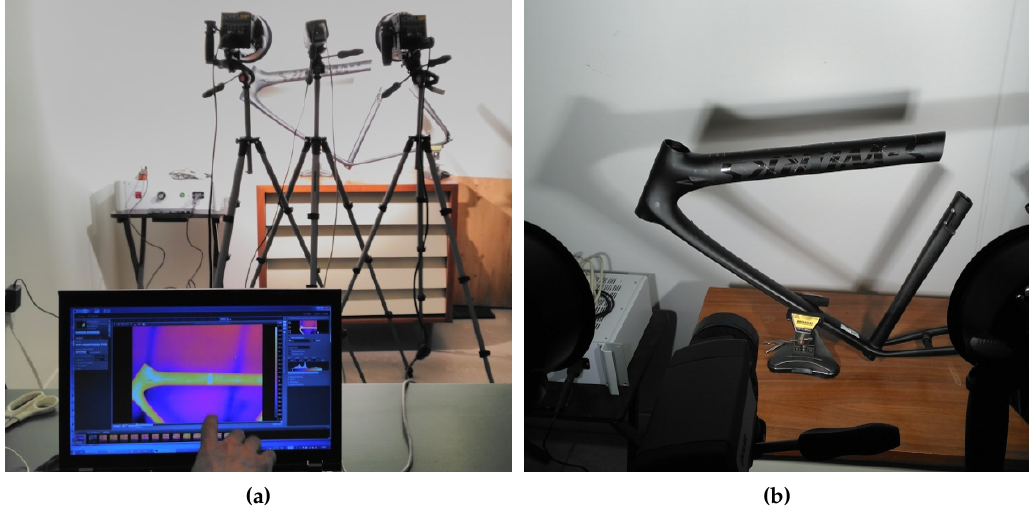
Figure 7. Inspection of the bicycle frame. ( a ) Complete view. ( b ) View from the camera